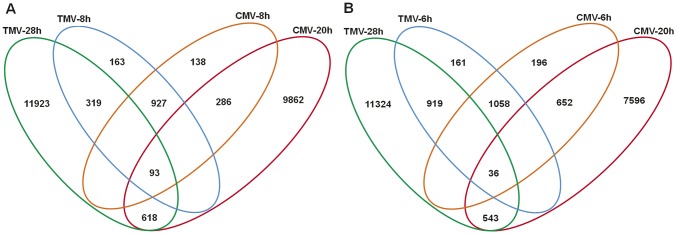
The generalized Venn diagrams with four datasets of TMV-6h, TMV-28h, CMV-6h and CMV-28h and their intersections.(A) Up-regulated genes and (B) down-regulated genes for each time point post-inoculation with TMV or CMV. All comparisons were made between inoculated and uninoculated (healthy) leaves at each time point.